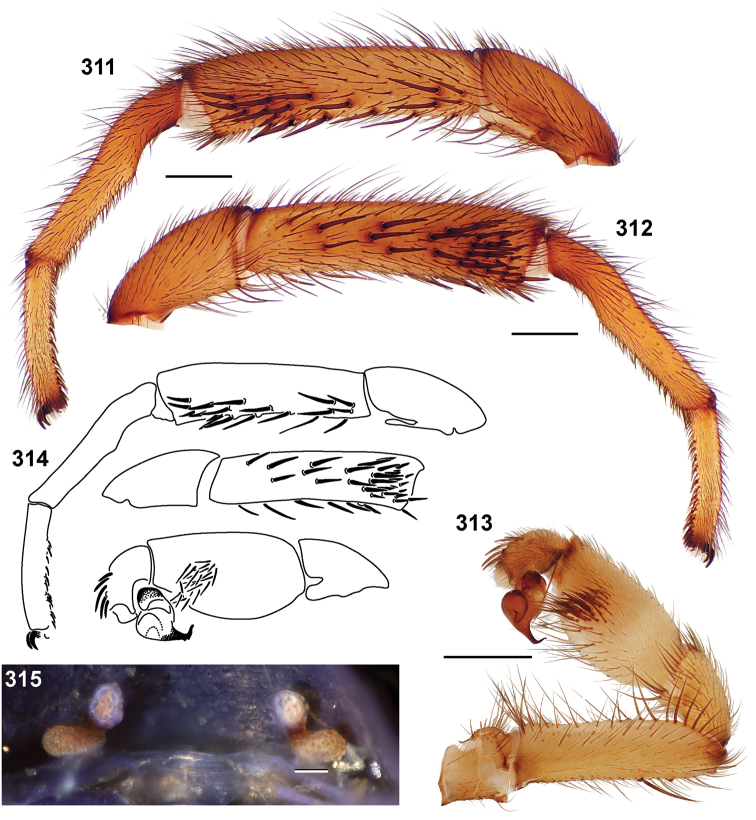
Aptostichus bonoi sp. n. 311–314 male holotype (AP399) from San Bernardino County; scale bars = 1.0mm 311 retrolateral aspect, leg I [806371] 312 prolateral aspect, leg I [806375] 313 retrolateral aspect, pedipalp [806377] 314 line drawings of leg I spination pattern and pedipalp; retrolateral aspect, leg I patella, tibia, metatarsus, tarsus; prolateral aspect tibia and patella; retrolateral aspect, pedipalp 315 female paratype (AP901) from San Bernardino County, cleared spermathecae [806378]; scale bar = 0.1mm.